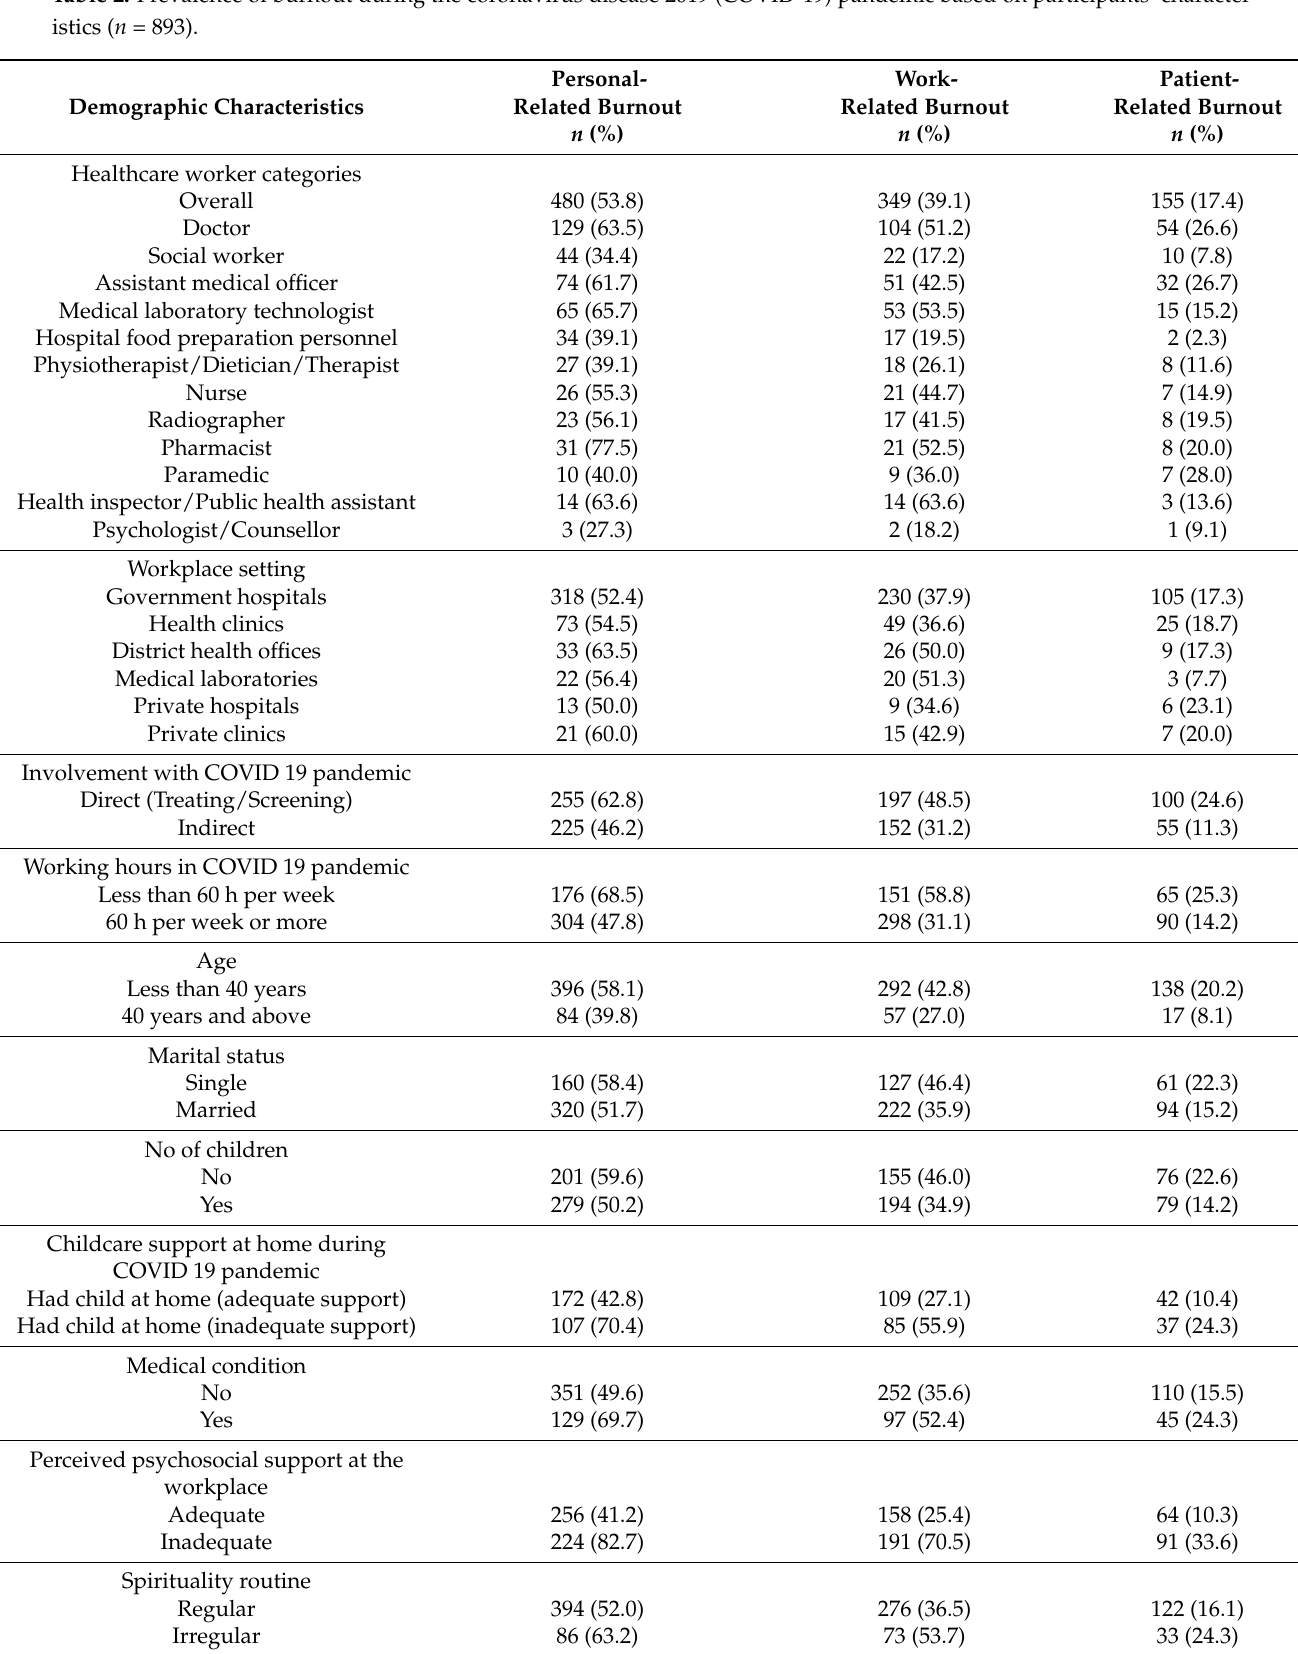
Table 2. Prevalence of burnout during the coronavirus disease 2019 (COVID-19) pandemic based on participants’ character- istics ( n =